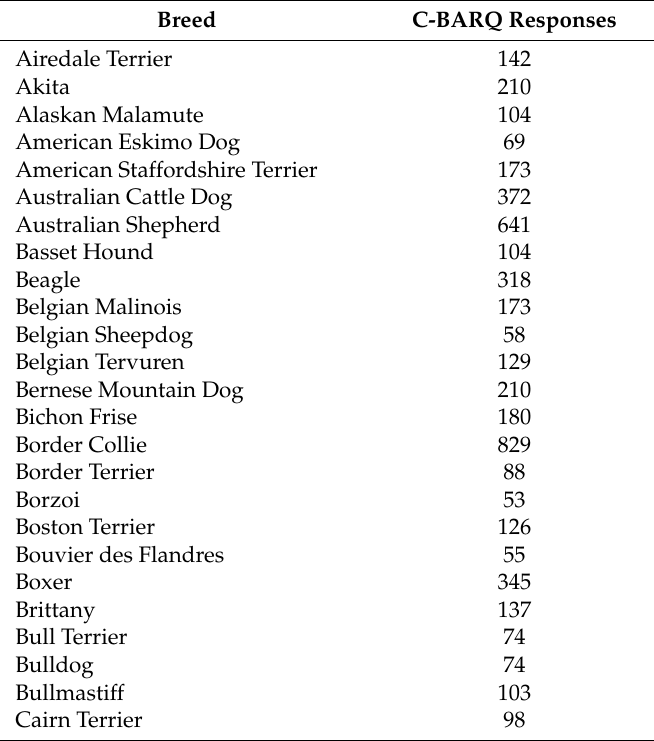
Table A1. Number of Canine Behavioural Assessment and Research Questionnaire (C-BARQ) Records for the breeds included in the cluster